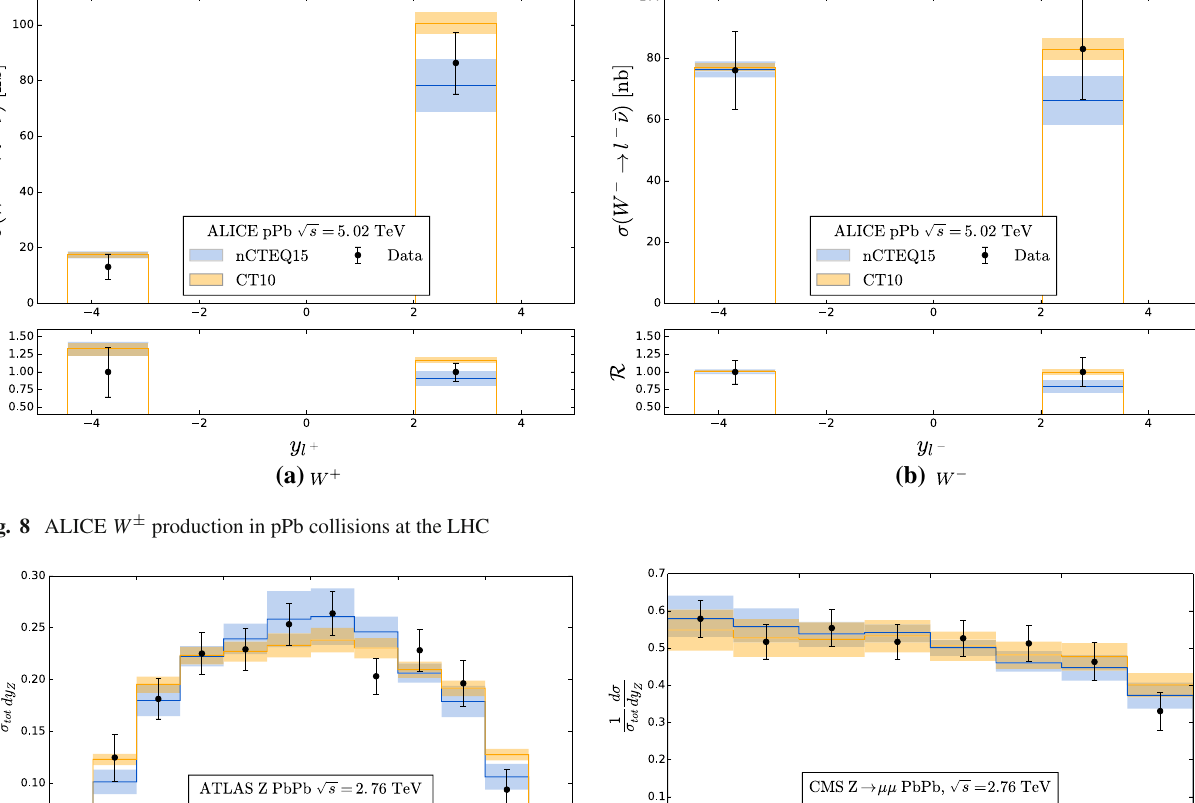
√ s = 2 . 76TeV as measured by